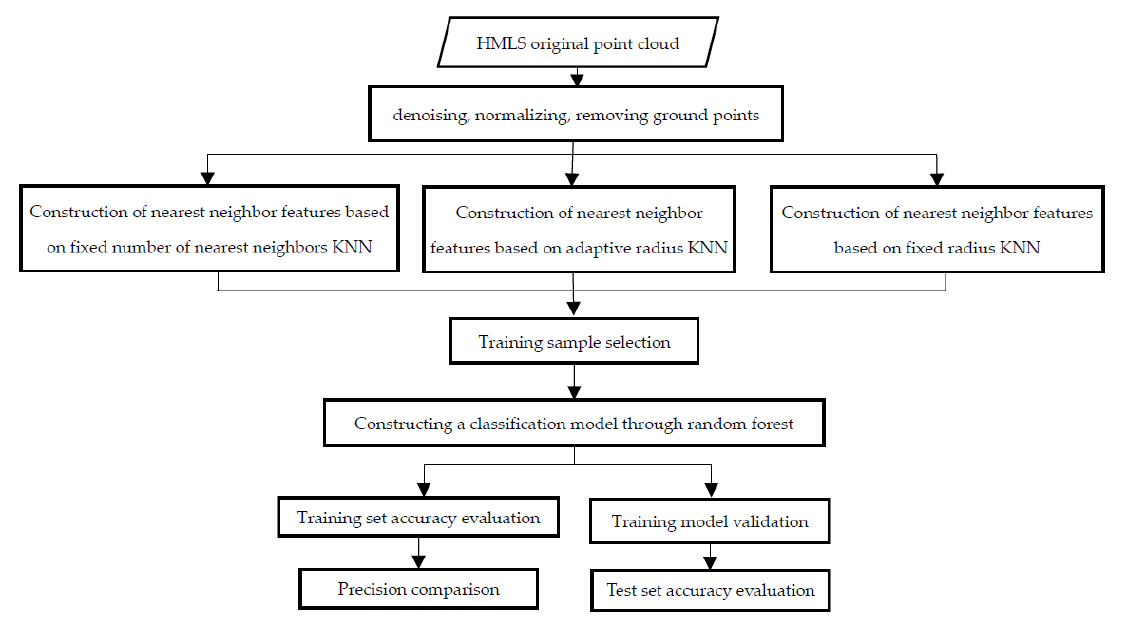
Figure 3. Technical flow